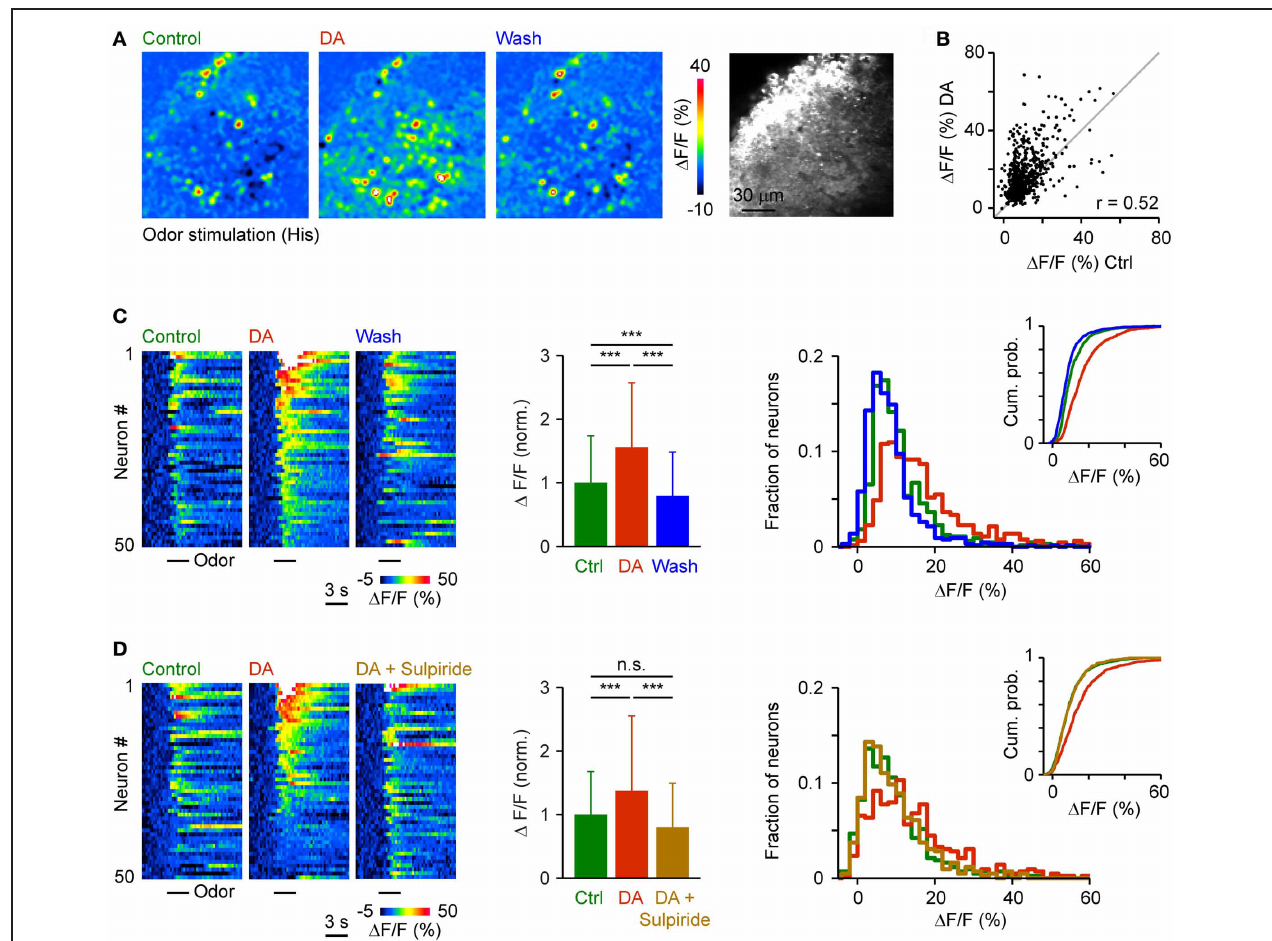
signals before, during and after exposure to DA ( n = 658 neurons from 20 fish; normalized). Right: Distribution of response amplitudes before, during and after DA exposure. Inset shows cumulative probability distribution. (D) Calcium signals of 50 randomly selected neurons (left) and mean calcium signals of all neurons ( n = 278 neurons from 8 fish; center) and amplitude distributions (right) before DA, during the presence of DA, and after addition of sulpiride (50 µ M). ∗∗∗ P < 0 . 001; n.s., not